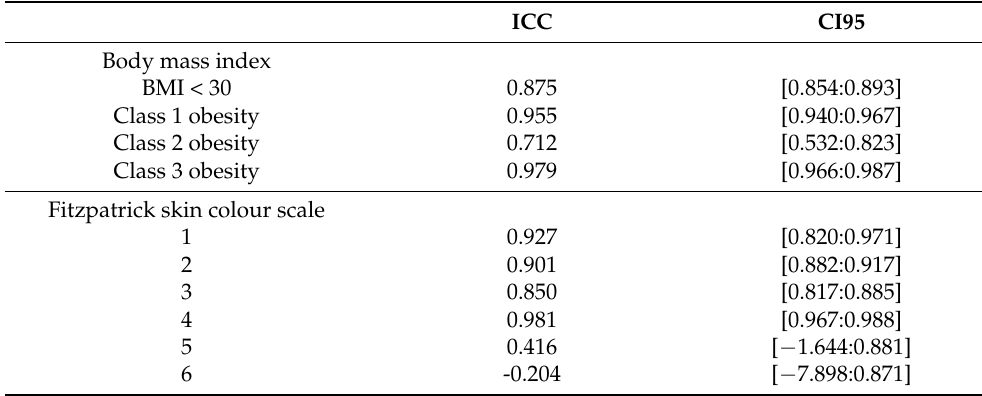
Table 3. Intersystem concordance between rPPGc and gold standard according to body mass index (BMI) and phototype.